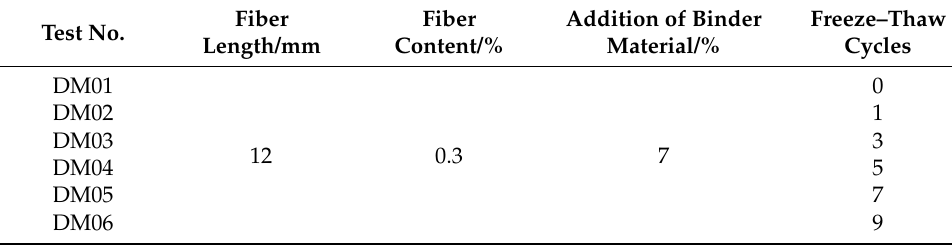
Table 4. Design of dynamic triaxial testing for